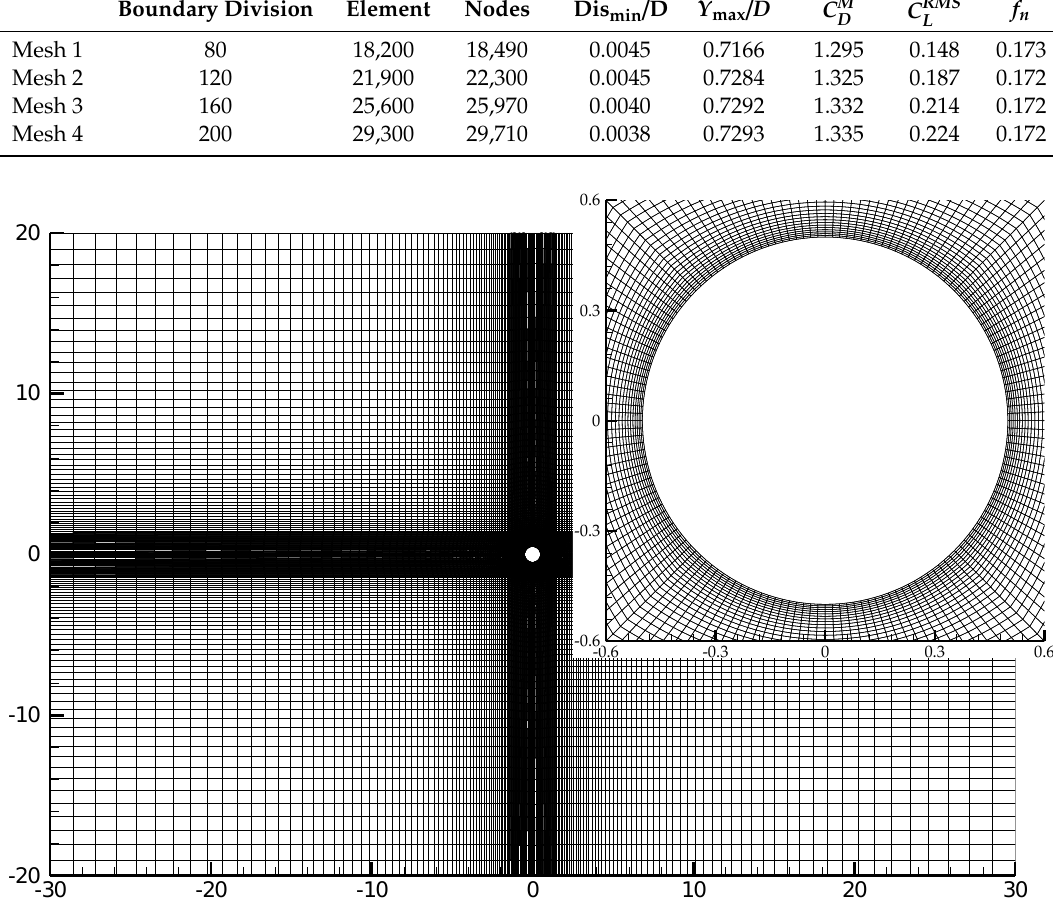
Figure 4. Sketch of mesh 3 in the model validation.